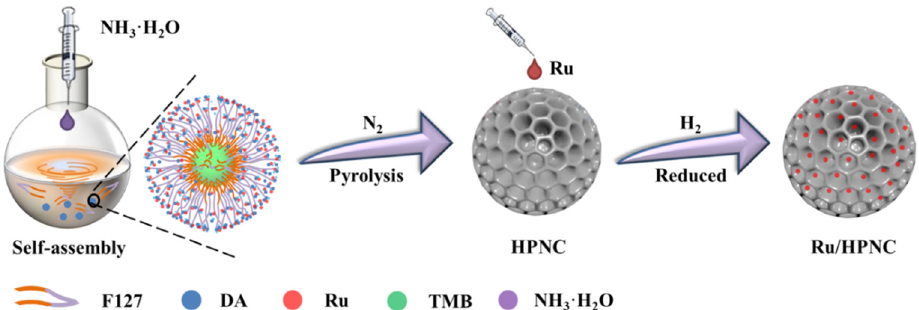
Figure 4. The preparation procedure of Ru/HPNC catalysts. Reprinted with permission from Ref. [31]. Copyright © Elsevier Inc. 2022.